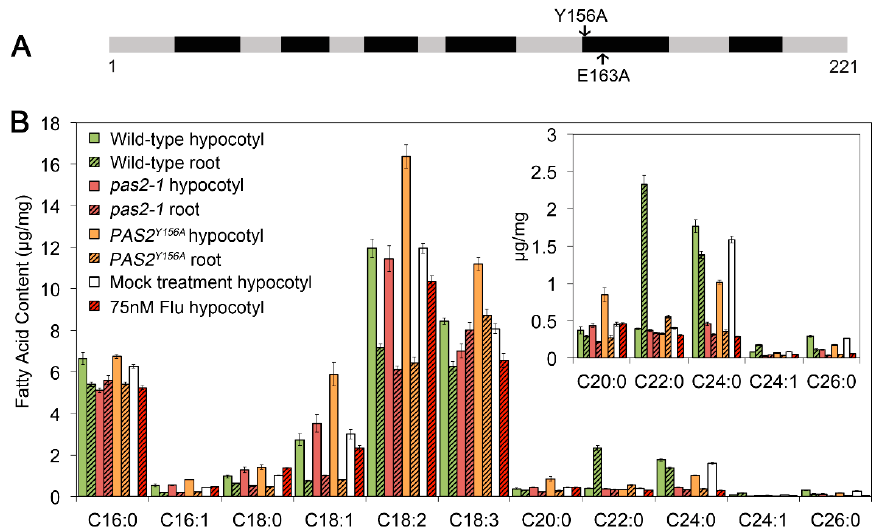
Figure 5. Both disruption of PAS2 ′ s dehydratase activity and pharmacological inhibition lead to VLCFA depletion in hypocotyls and roots. ( A ) A schematic graph showing the position of two point mutations PAS2 Y156A (left) and PAS2 E163A (right), indicated by arrows. ( B ) Fatty acid methyl esters (FAMES) analysis of hypocotyls of 4-day-old etiolated seedlings and roots of 15-day-old light-grown seedlings. The pPAS2:: GFP- PAS2 Y156A plants showed di ff erential extend of VLCFA decrease in hypocotyls and in roots; and 75nM Flu treatment mimicked the VLCFA pool in the pas2-1 mutants, characterized by reduction in VLCFA content and increased short chain fatty acid portion. Moreover, the Flu treatment caused more severe depletion of VLCFA in the hypocotyls, comparing to pPAS2:: GFP- PAS2 Y156A